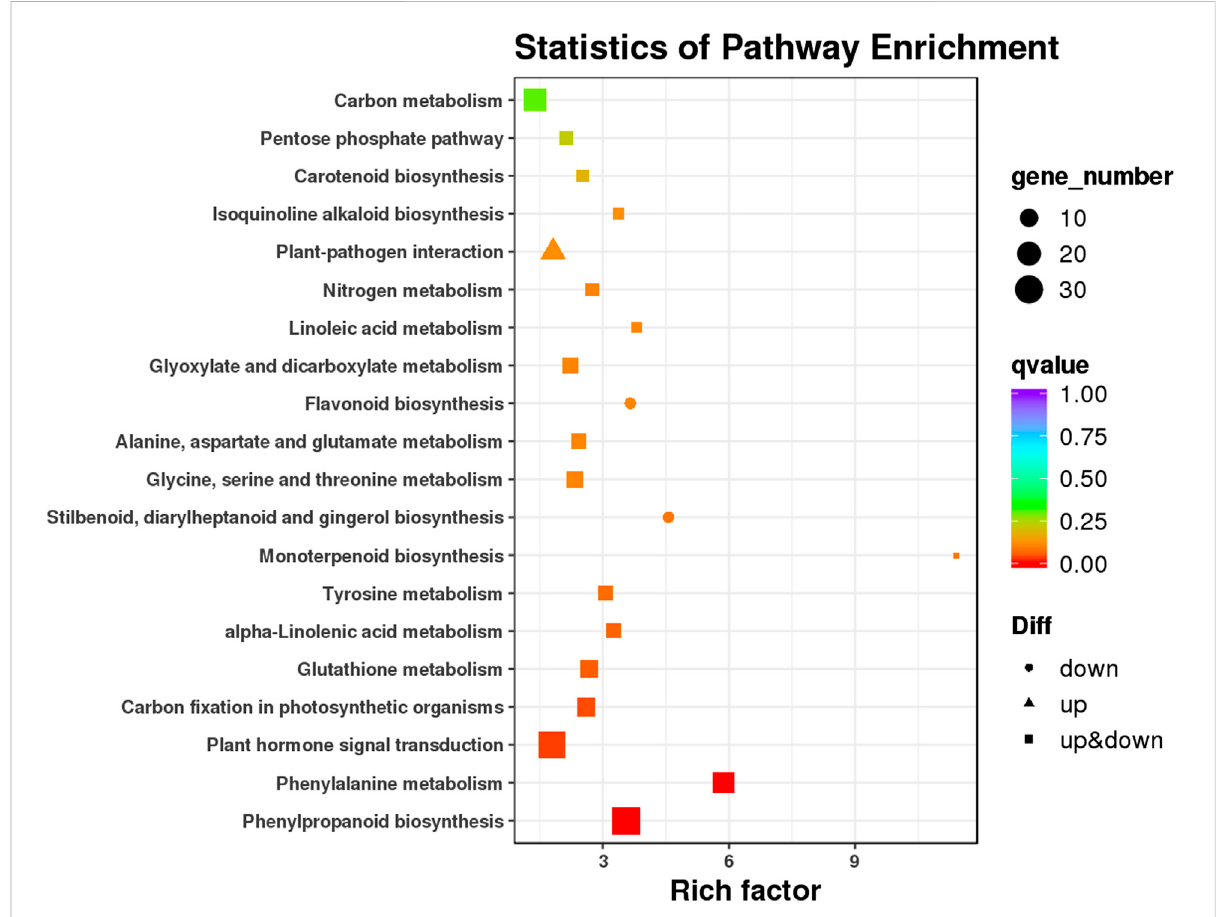
FIGURE 4 Statistics of Kyoto Encyclopedia of Genes and Genomes (KEGG) pathway enrichment